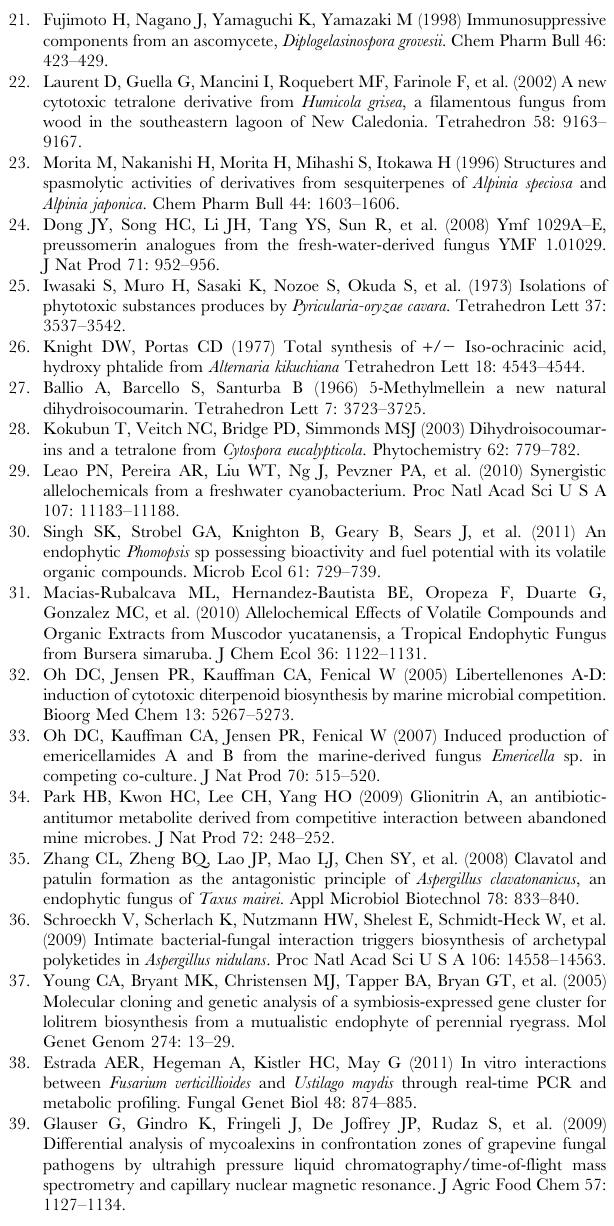
Figure S1 CD spectrum of isosclerone (1). Recorded in MeOH at 22 u C ( c , 10 2 2 ) (TIF)